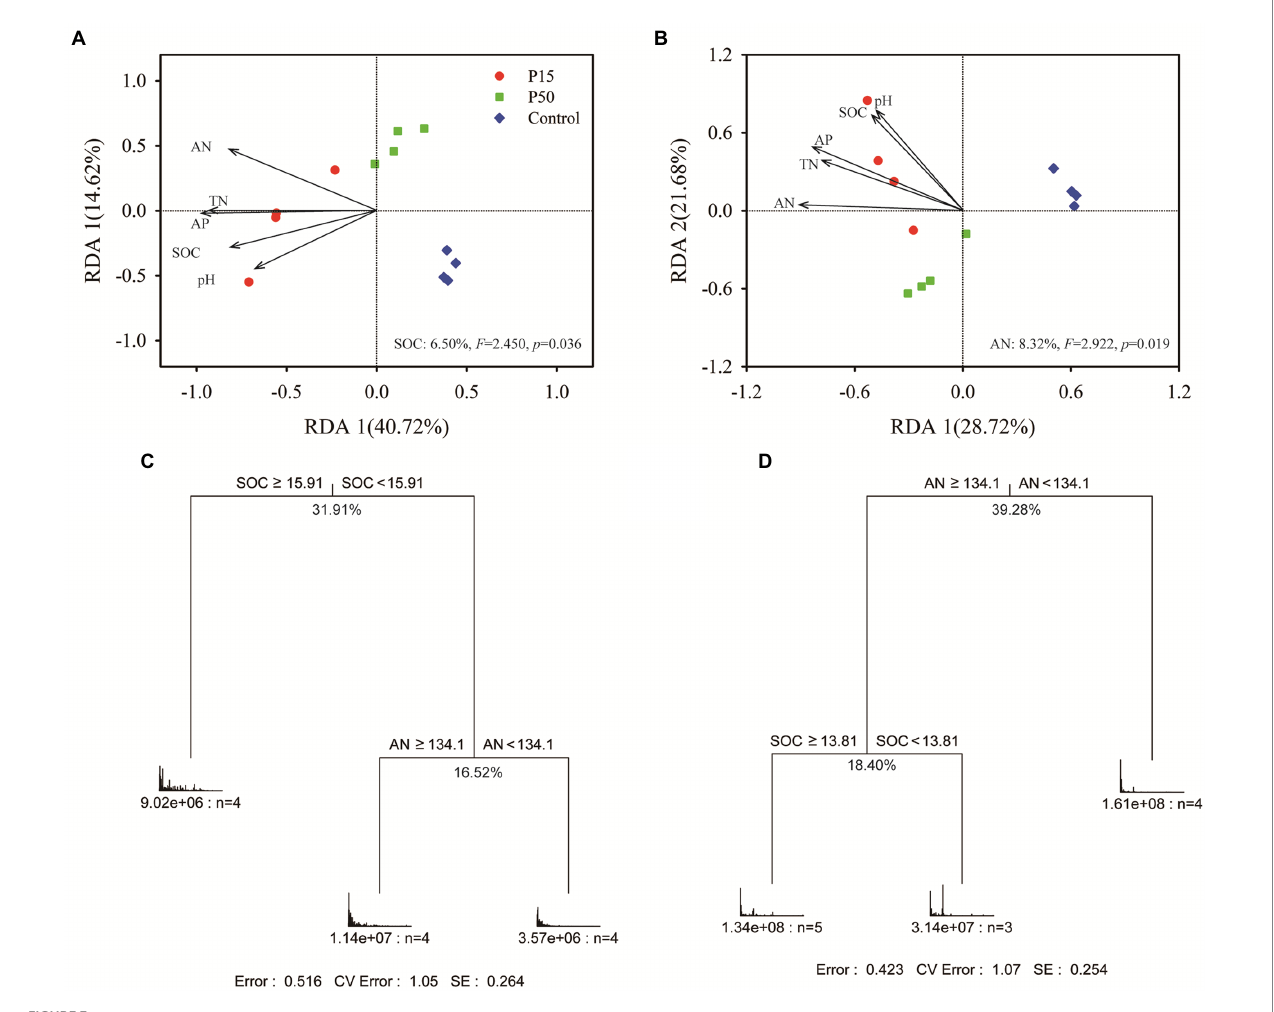
FIGURE 3 Redundancy analysis (RDA) between the soil bacterial (A) , fungal (B) community and fertility indexes at the OTU level in the Cinnamomum camphora coppice planting. P15, point under the tree canopy; P50, point between trees; Control, point in the abandoned land. Multivariate regression trees (MRT) of soil bacteria (C) , fungi (D) community composition and fertility indexes. Numbers under the crosses of each split indicate percentages of variance explained by the